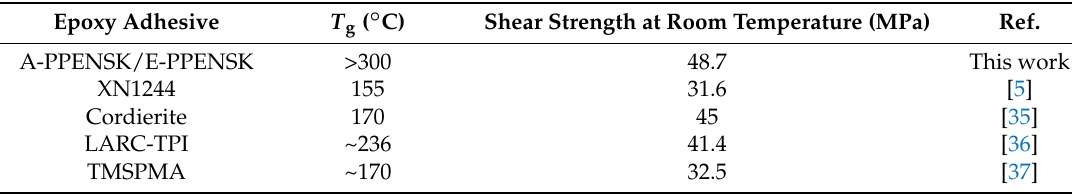
Table 2. Comparison the presented results with literature